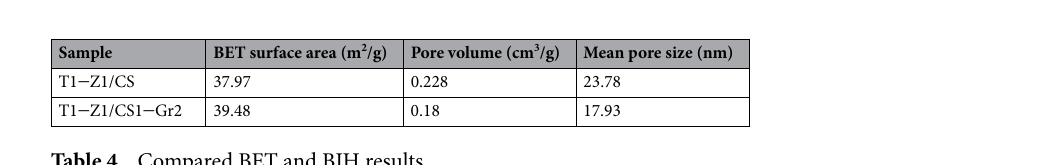
Table 4. Compared BET and BJH results.